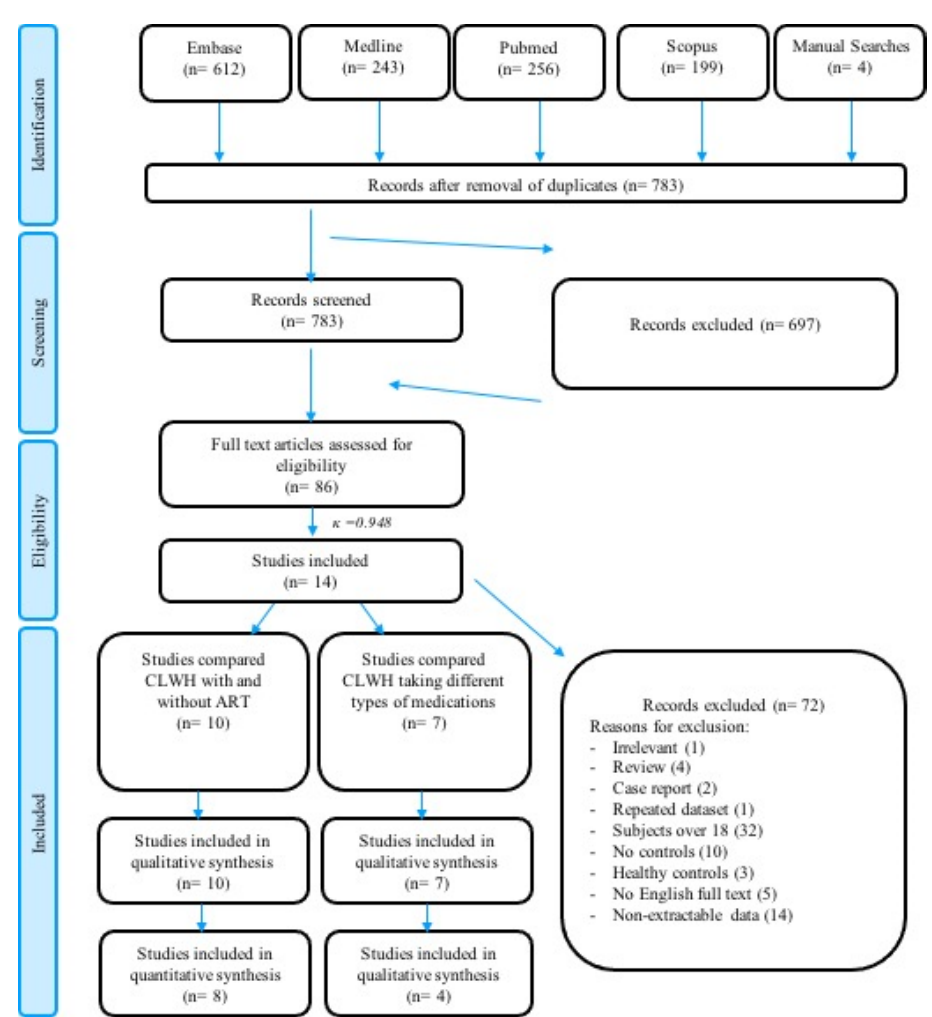
Figure 1. PRISMA flowchart of the current review.